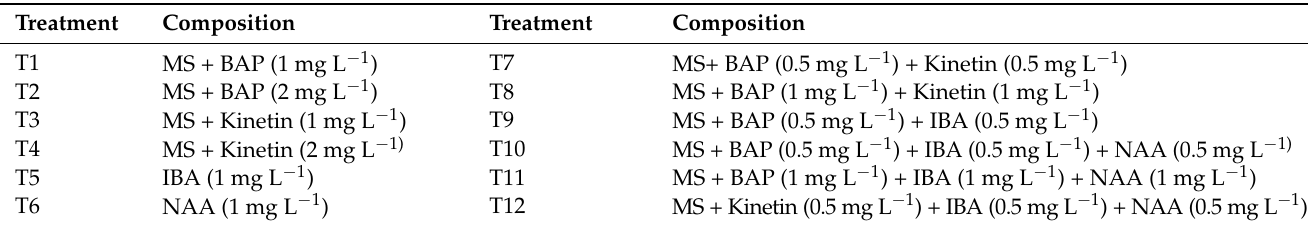
Table 2. Different media compositions for shoot induction.